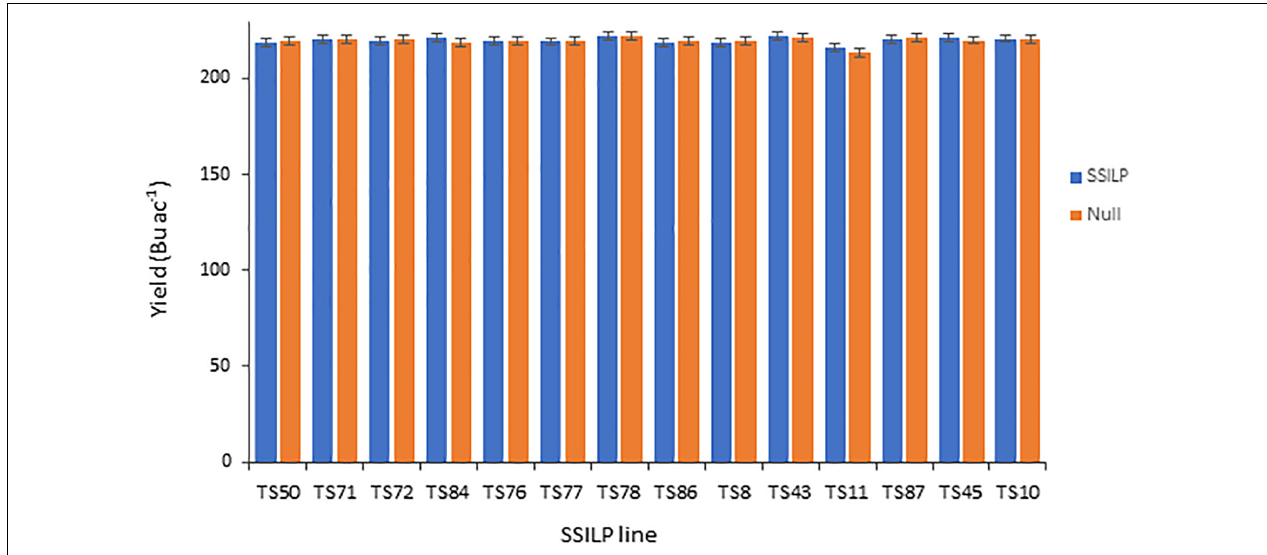
FIGURE 6 | Grain yield of maize hybrids containing SSILP and corresponding nulls. Yield trials were carried out in the United States corn-belt in 2017. Each bar represents data from three hybrids at 12 locations. All analyses were implemented using ASReml with output of the model presented as best linear unbiased prediction (BLUP). The yield of the SSILP hybrids were not significantly different from their corresponding nulls ( P > 0.05, two-tailed